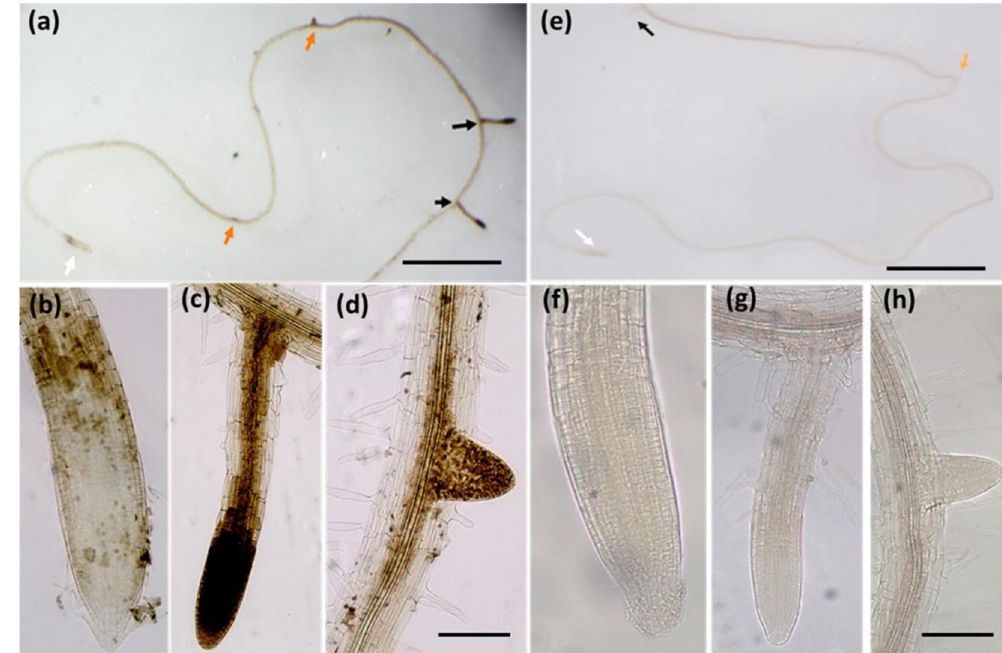
Figure 7. Total ROS in PR and LR by during lethal salinity. Arabidopsis plants subjected to salt stress (200 mM NaCl) at different time points (0 h,12 h,24 h,48 h, & 72 h) were stained with 3,3 ′ -Diaminobenzidine-HCl (DAB- HCl). Images ( a – d ) show representative DAB staining in the root 48 HAS. Images ( e – h ) present DAB staining in roots of plants that were treated with NaCl for 48 h NaCl in presence of 10 µ M DPI. The white arrow indicates PR of ( b ) 48 h salt and ( f ) 48 h salt + DPI whereas ( c & g ) black and ( d , h ) orange arrows mark the lateral and emerging lateral roots under above mentioned conditions, respectively. ( a , e ) Were captured by trinocular Stereo Microscope SZ61 and (b-d &f-g) by inverted microscope AE2000. In ( a , e ) scale bar = 0.5 cm. In ( b – d ) and ( f – h ) the scale bar = 50 µ